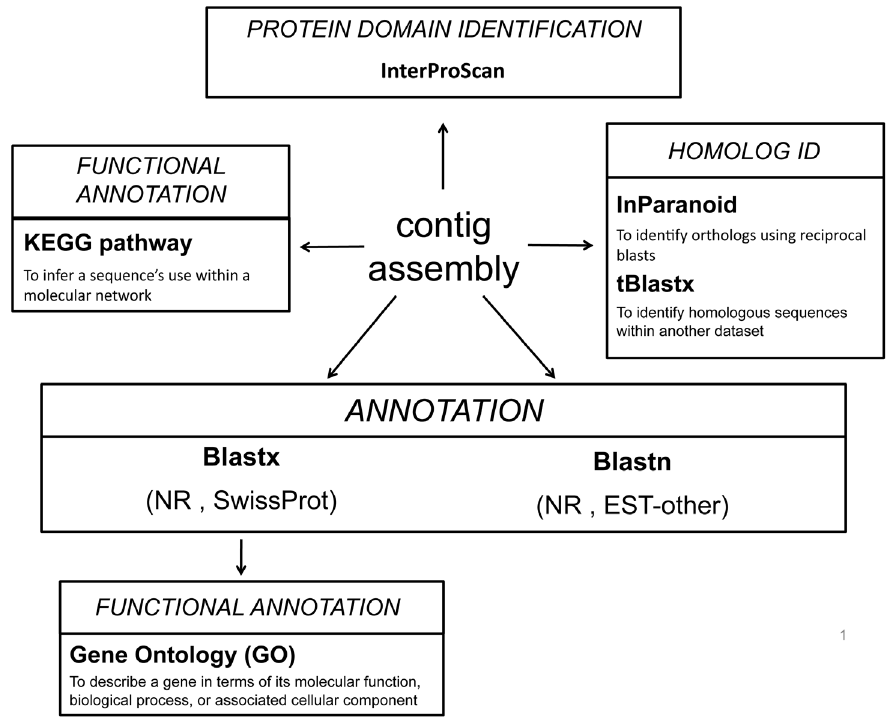
Figure 2. Sequence of analyses performed to assemble and annotate scallop eye transcriptomes.